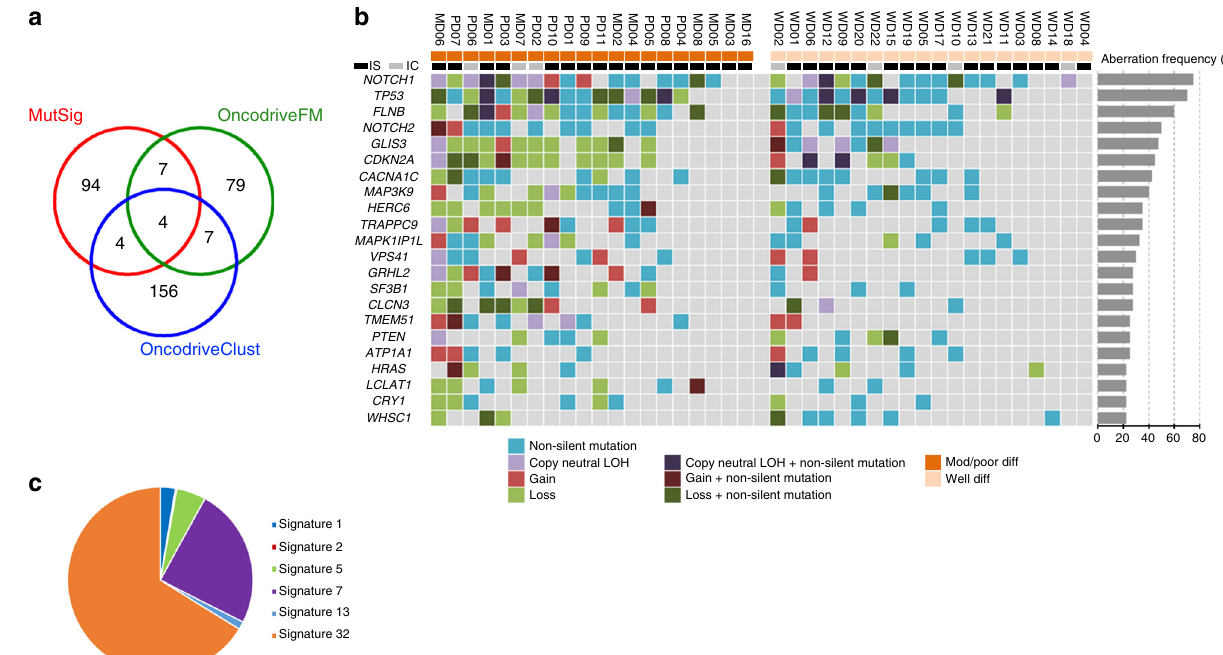
Fig. 3 Twenty-two SMGs identi fi ed in 40 cSCC samples. a Venn diagram of overlap of signi fi cantly mutated genes as assessed by MutsigCV, OncodriveFM and OncodriveClust. b Mutation OncoPrint of the 22 SMGs identi fi ed by at least two of the three methods, with their aberrational frequencies also indicated with percentage bars. IS immunosuppressed, IC immunocompetent. c Pie chart of the mutational signature contribution to SMG